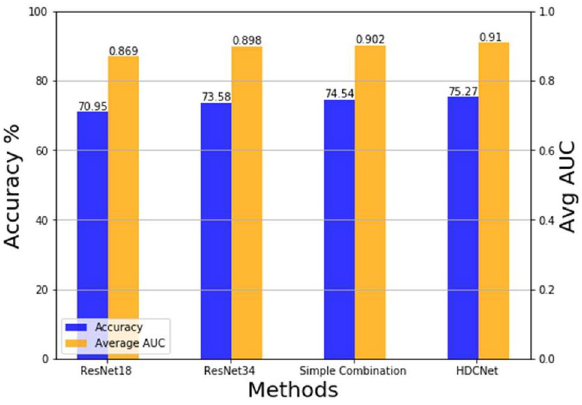
Figure 3. Comparison between different methods.